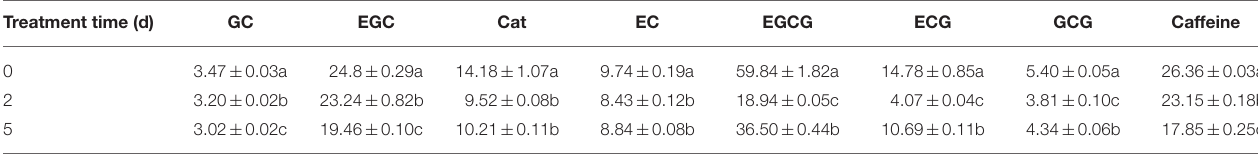
TABLE 1 | Drought stress-induced changes in the amount of individual catechins and caffeine (mg · g − 1 DW). Treatment time (d)